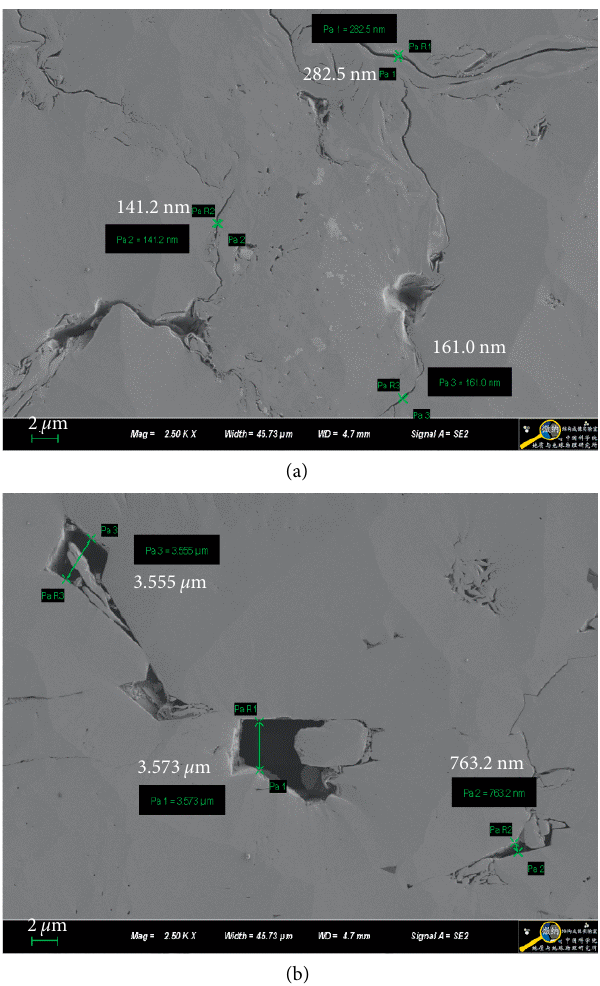
Figure 3: The SEM of tight oil reservoir